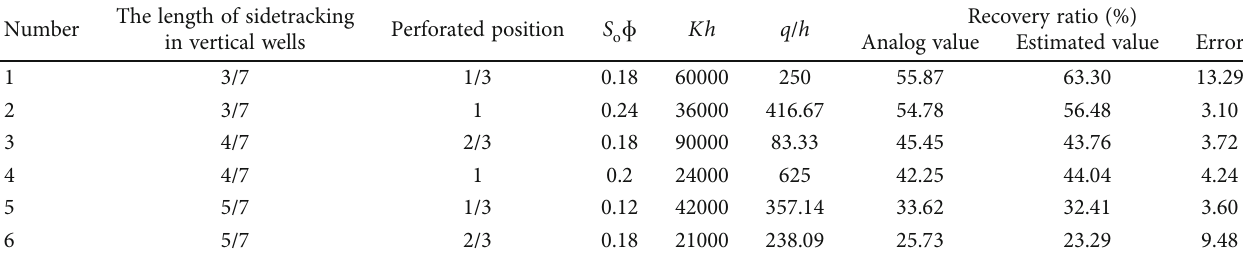
Table 4: Comparison of numerical simulation results and calculation